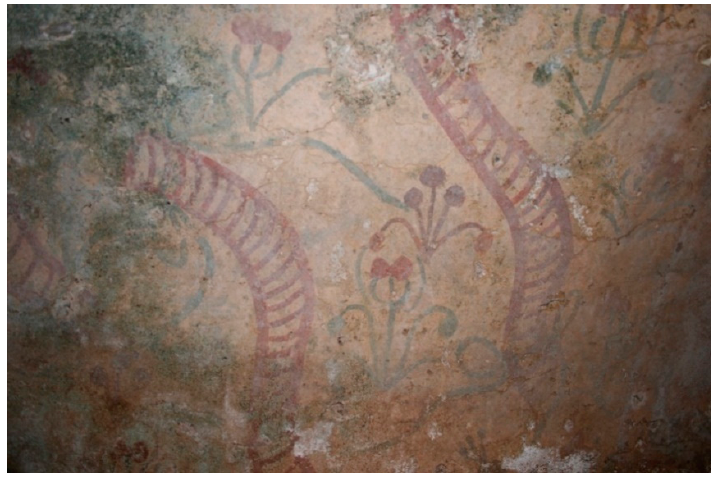
Figure 22. Sardis, Kâgirlik Tepe Tomb (Appendix A.7), detail. Author photo.